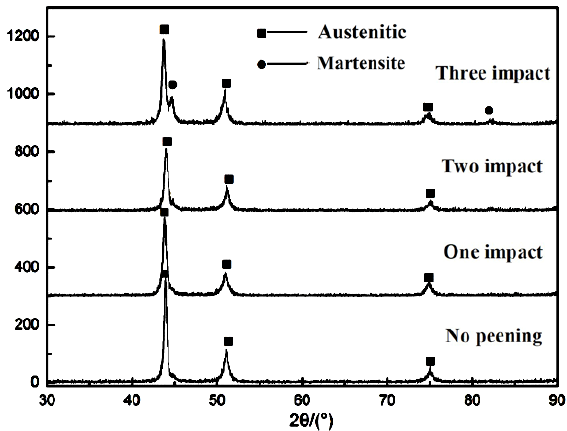
Figure 7. XRD patterns of different samples of 316L stainless steel.